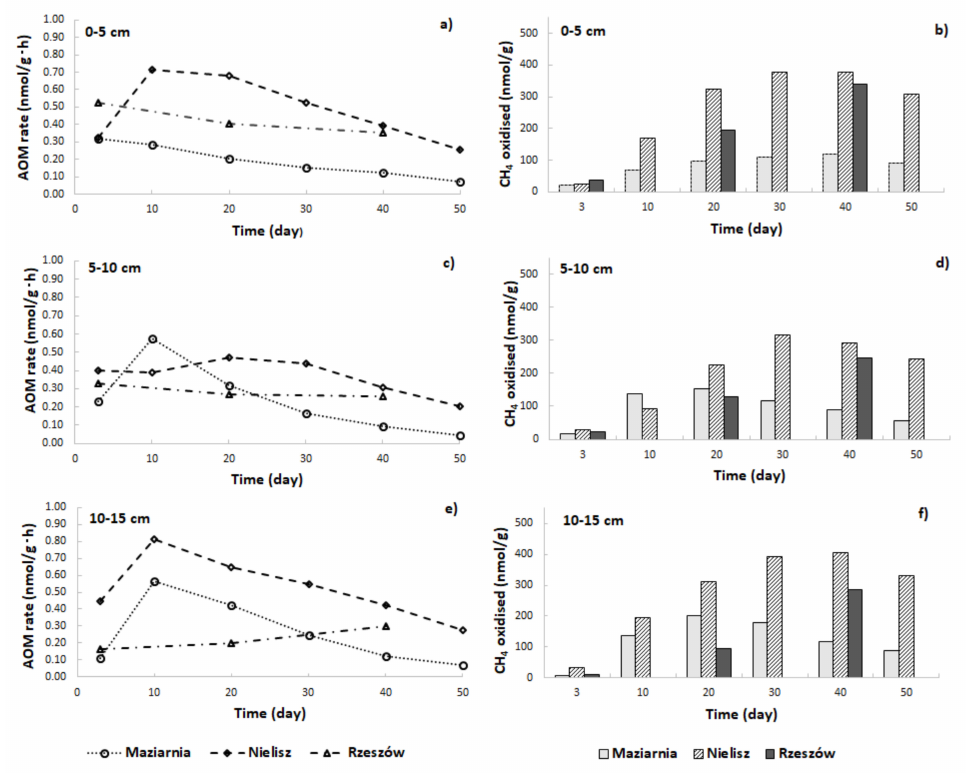
Figure 3. Changes in AOM rates – panels ( a,c,e ) and amounts of CH 4 oxidised – panels ( b,d,f ) over the time of incubation of